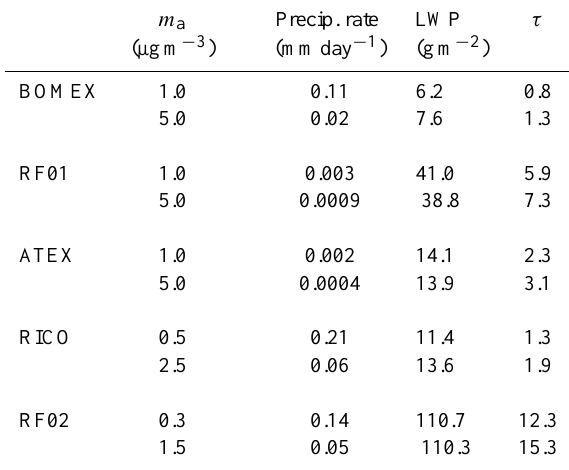
Table 1. The surface precipitation rate (Precip. rate), liquid water path (LWP), and cloud optical depth ( τ ) at different sulfate